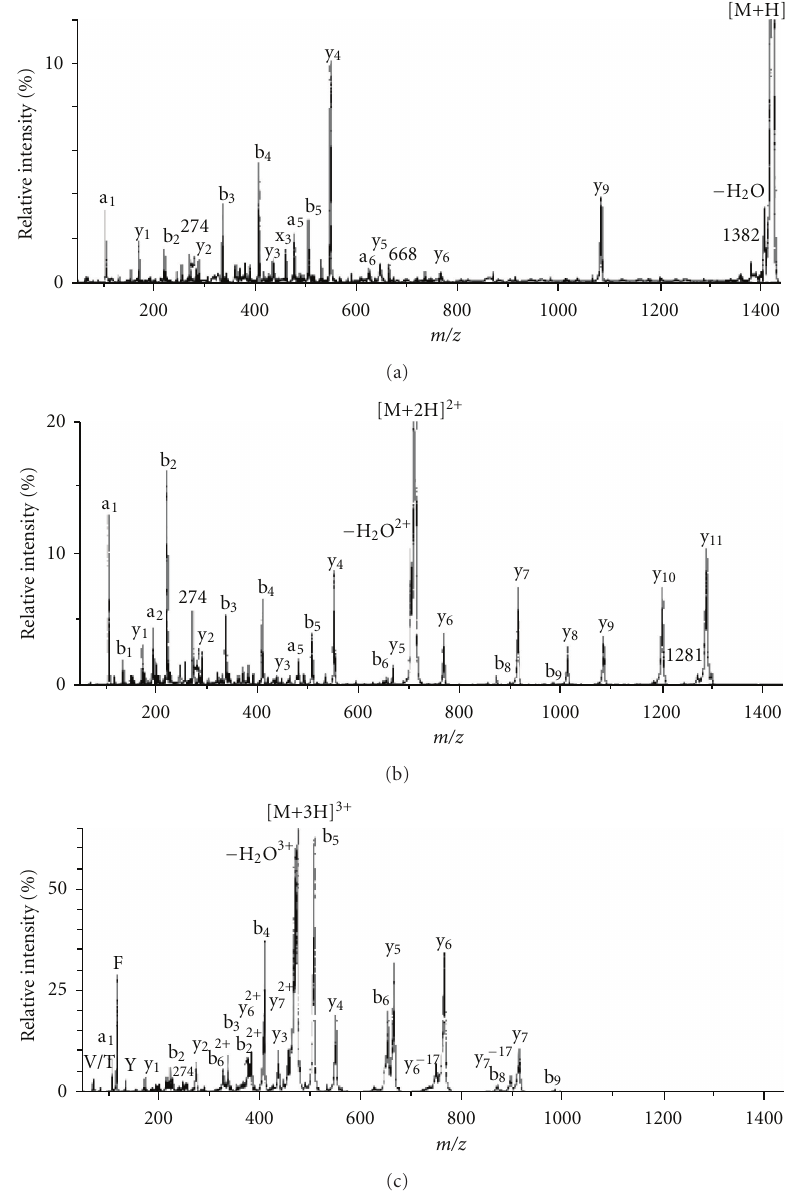
Figure 18: CID-MS/MS spectra of di ff erent protonated forms of the peptide HSDAVFTDNYTR: (a) CID of singly protonated peptide [M + H] + , (b) CID of doubly protonated peptide [M + 2H] 2+ , and (c) CID of triply protonated peptide [M + 3H] 3+ . (Reprinted with permission from Analytical Chemistry [157], Copyright 1993, American Chemical